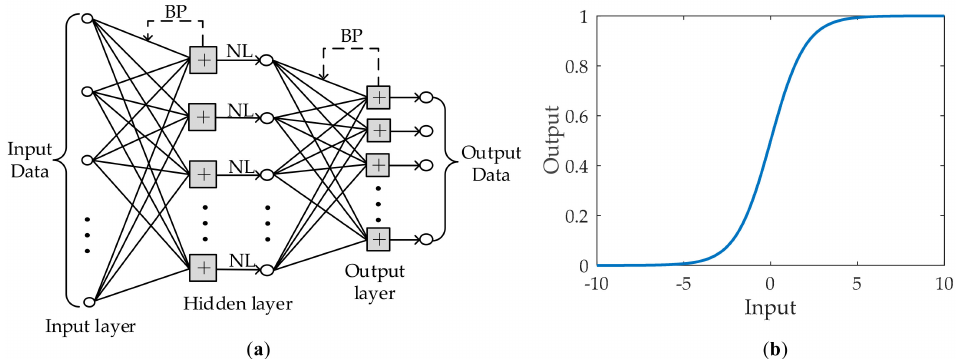
Figure 2. ( a ) Three-layer perceptron; ( b ) Curve of non-linear (NL) unit.